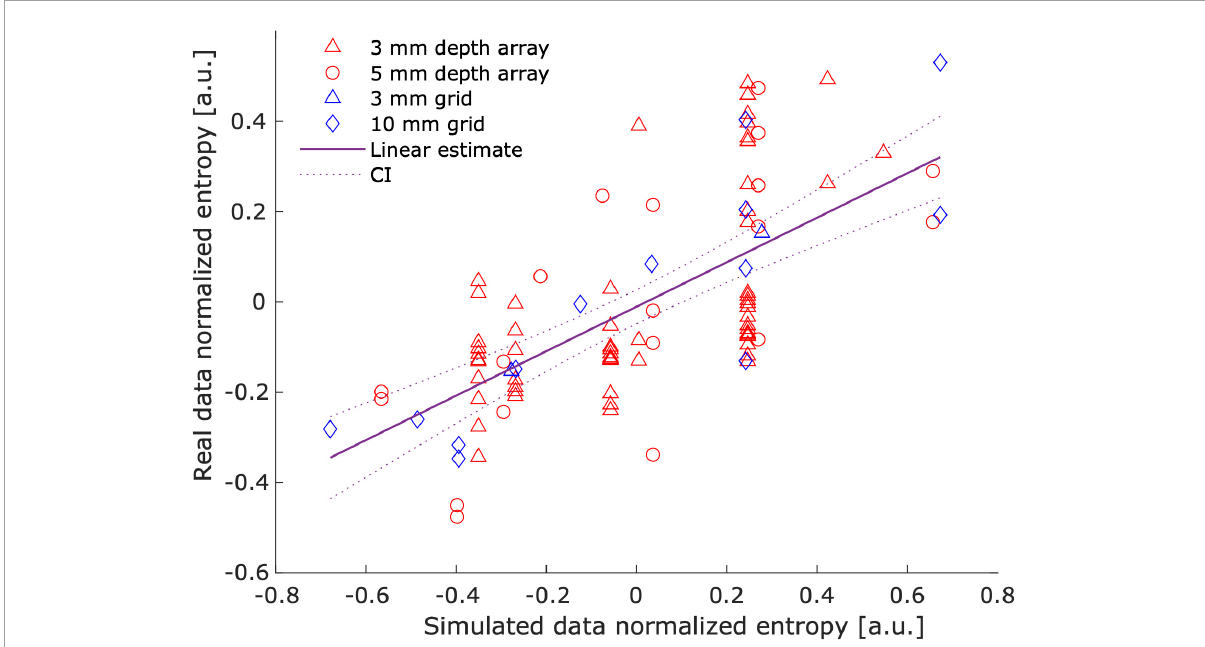
FIGURE8 Correlation between real and simulated noise. The figure illustrates that real data noise linearly correlates with simulation noise. The entropy of the cross-correlation between 2D histograms was used as a proxy for noise levels. Individual marks represent a “best fit” simulation – real data pair. The best fit simulation was determined by the highest correlation between their corresponding 2D intensity-radius histograms (see Supplementary Figure 8 ). Entropy values were normalized (mean subtracted) to account for the effect of artifact